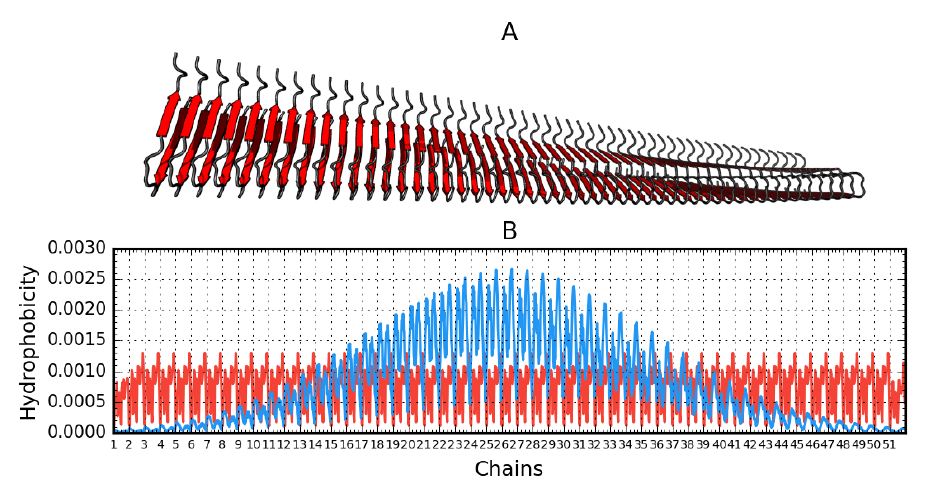
Figure 4. Aβ (15 – 40) 51 (2MPZ*) structure generated based on operations that result from fibril Contains 51 chains. A —3D presentation. B —theoretical (T, blue) and observed (O, red) hydrophobicity symmetry. Contains 51 chains. A — 3D presentation. B — theoretical (T, blue) and observed (O, red) density distribution in this hydrophobicity density distribution in this fibril.